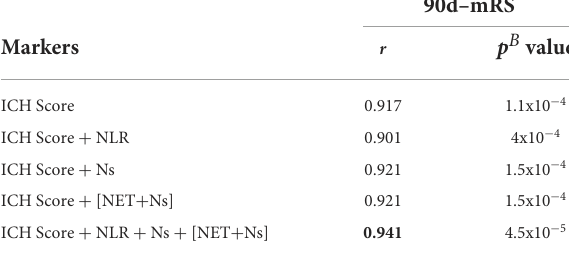
(Supplementary Table S1). Spearman rank correlation matrix analysis did not detect significant correlation coefficients with sICH severity measures. A moderate correlation was detected ( r = 0.5) for IL-6 with GCS score, sC5b-9 with ICH score and 90-day mRS, and mt/nDNA ratio with GCS score and 90-day mRS (Supplementary Figure S1, Supplementary Table